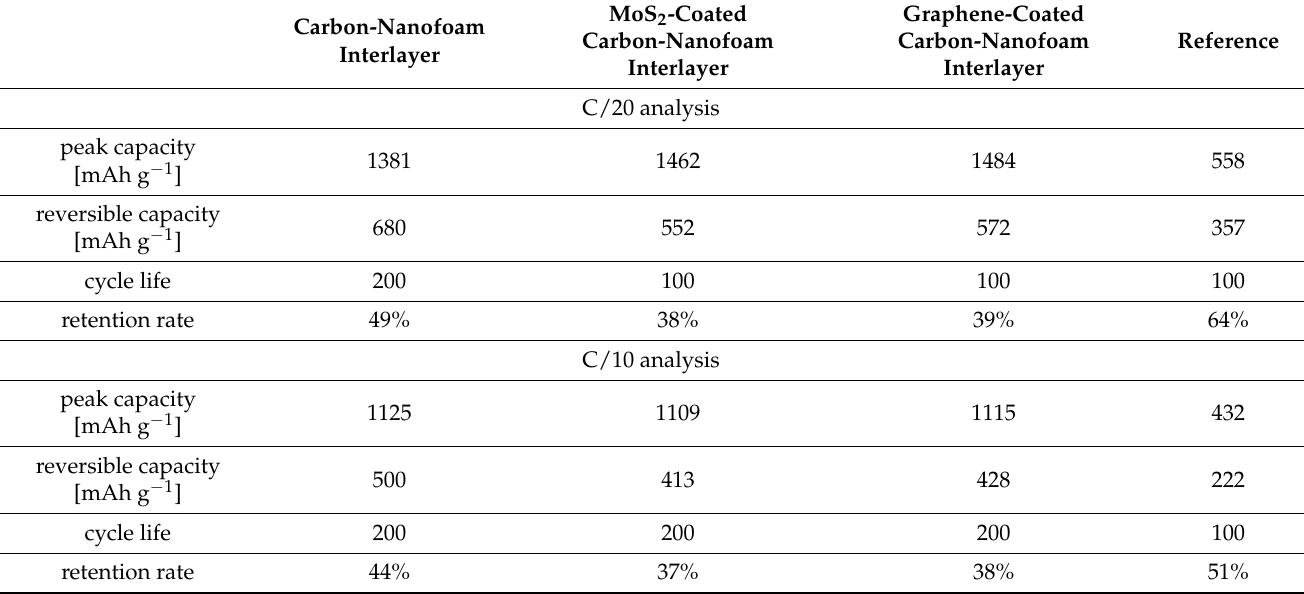
Table 2. Performance comparison of the cells with each type of interlayer at the C/20 and C/10